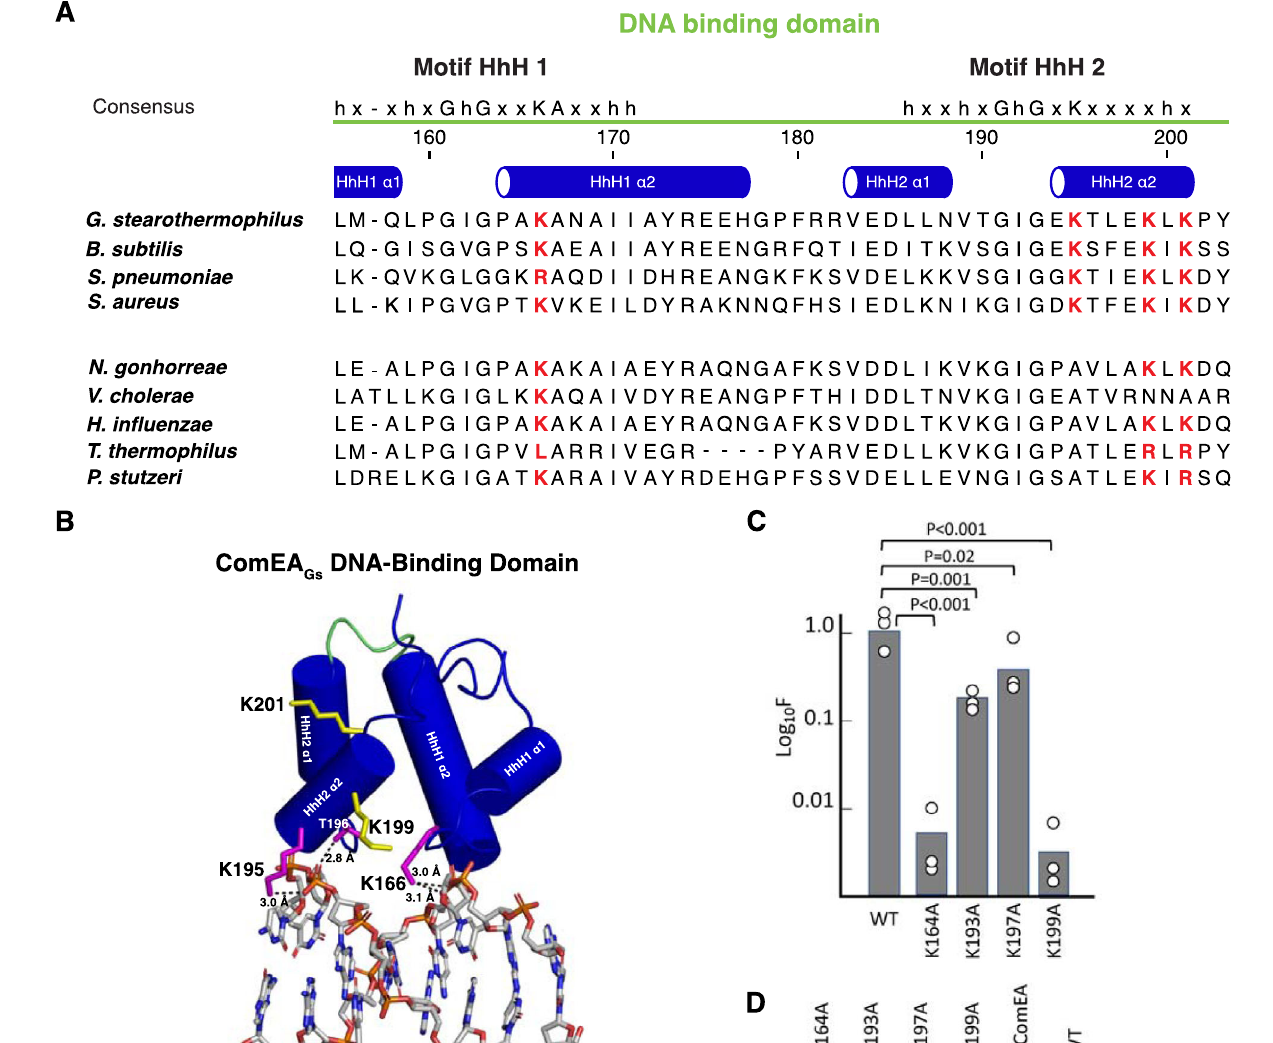
frequencies,normalizedtothewild-type(BD9007)valuesareplottedasbargraphs with the data points included. The mean normalized values with standard devia- tions for the mutants were 0.0054±0.004 (K164A), 0.23±0.066 (K193A), 0.54±0.22(K197A), 0.0031±0.0025 (K199A). The p valueswere determinedusing two-sided t-tests. D shows Western blots for the wild-type and mutant ComEA proteins obtained using anti-GFP antibody. This Western blot experiment was repeatedatotalofthreetimeswithnearlyidenticalresults. E EMSAanalysisofwild- typeComEA Gs ,ComEA-K166A,andComEA-K201A.TheEMSAanalysiswasrepeated atleasttwotimeswithnearlyidenticalresults.SourcedataareprovidedasaSource Data fi